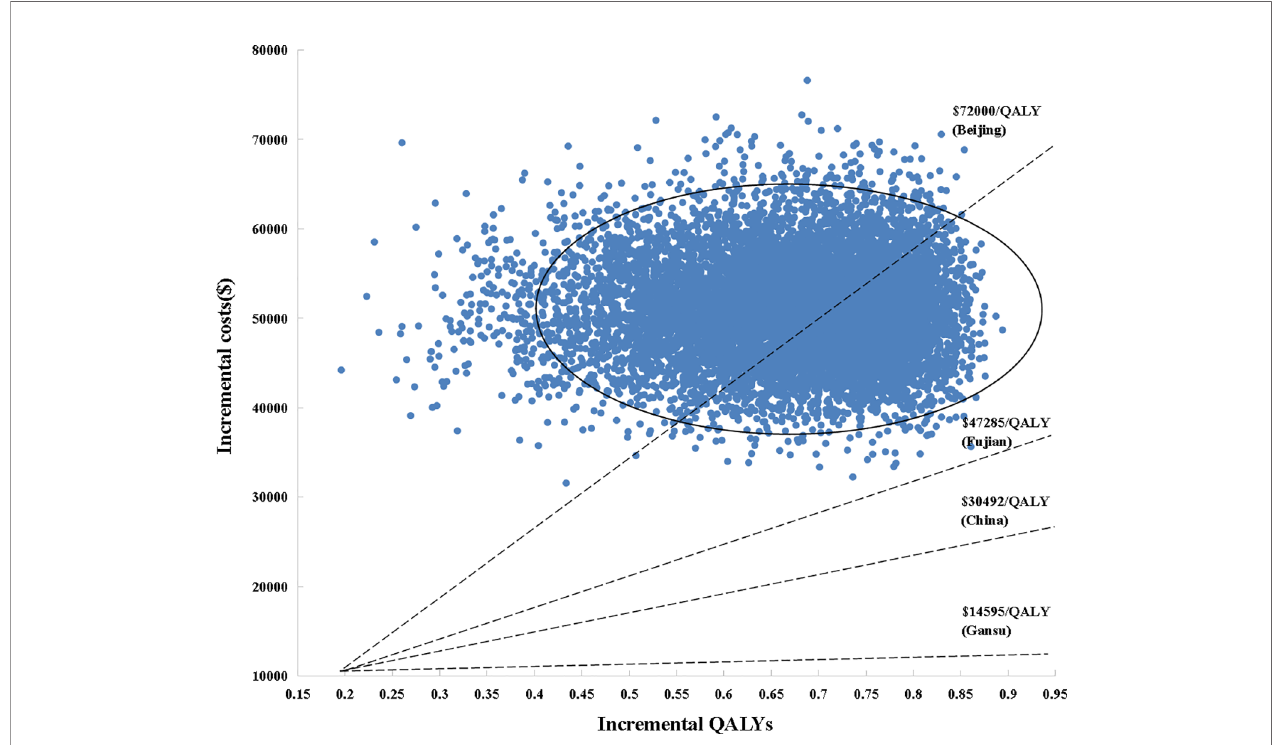
FIGURE 3 | Scatter plot of probabilistic sensitivity analysis. Each point in the scatter plots corresponds to one sample of parameter values. QALYs, quality-adjusted life years; WTP,